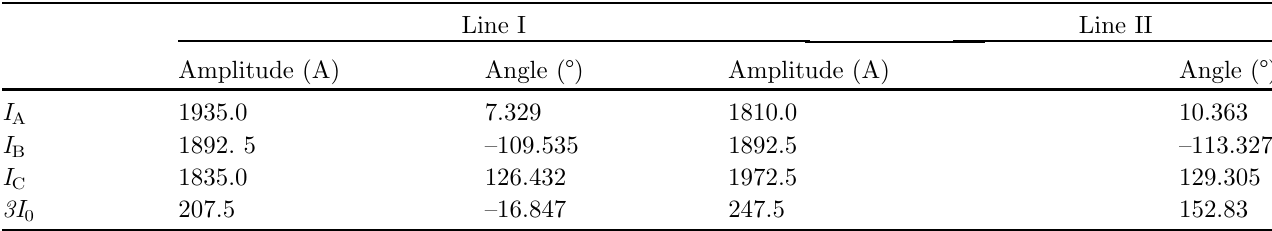
Table 1. Amplitude and phase angle of line current on YD side.